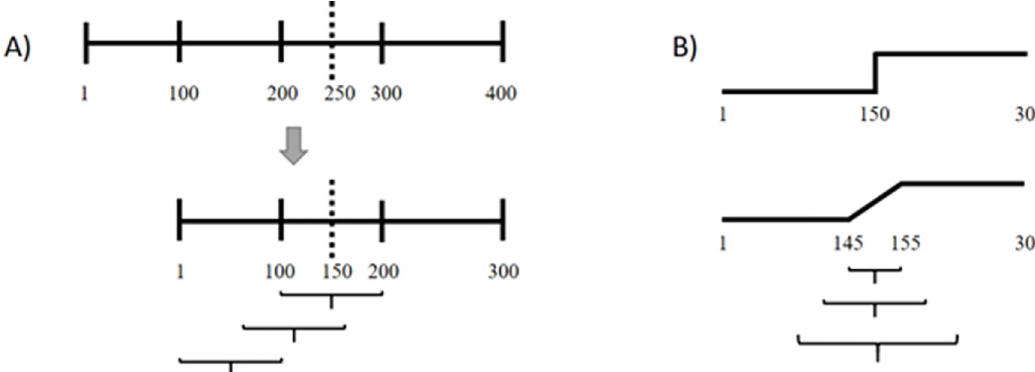
Fig 2. Generation of the time series. A) Simulations with 400 iterations (data points) were generated. The first 100 data points were discarded to allow for saturation effects (transient period). A transition point (dashed line) was launched at T = 250 in the original time series, corresponding to T = 150 in the adjusted time series. Depending on where the transition point should be, the corresponding interval of 100 data points (brackets) was chosen and assessed with the algorithm. The upper bracket shows the interval where the transition point is located at the middle of the time series, the bracket in the middle the interval where the transition is at the end, and the lower bracket the interval without a transition point (to assess the rate of false positive results). B) The effects of prolonged periods of changes were investigated by linearly increasing the control parameters over several time points (brackets).